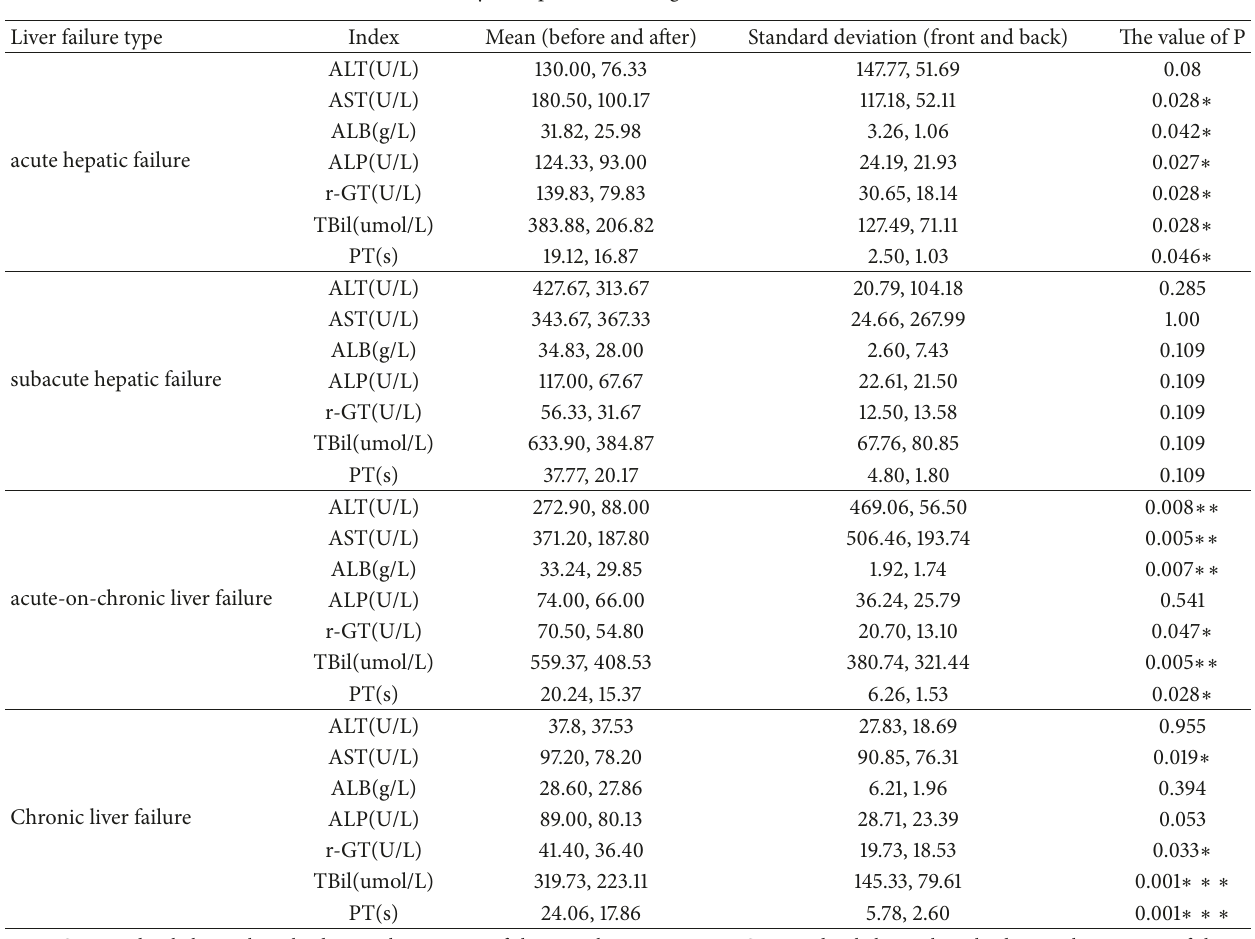
Table 7: Clinical analysis of plasma exchange in the treatment of liver